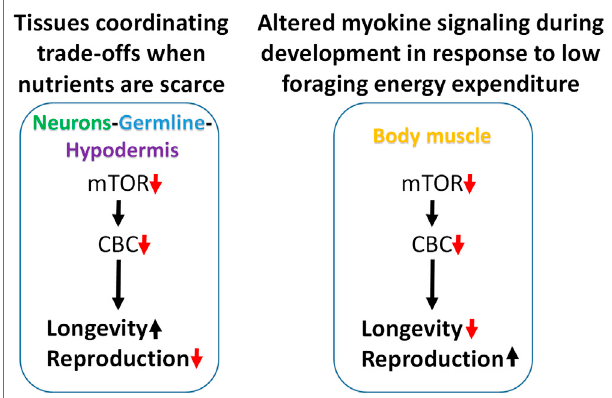
FIGURE 7 | Modeling trade-offs between nutrient sensing, lifespan and reproduction. Low translation through the CBC downstream of mTOR increases lifespan and reduces fecundity when carried out selectively in neurons, germline, or hypodermis,suggestingthat these tissues may be responsible for coordinating somatic protection under low nutrient conditions (left). Conversely, low translation in body muscle can shorten lifespan and increase reproduction under normal feeding conditions. Given the positive connection between muscle use and translation, and that less energy is expended on foraging when nutrients are abundant, low translation in body muscle may be a signal that conditions are highly conducive for maximizing reproductive output